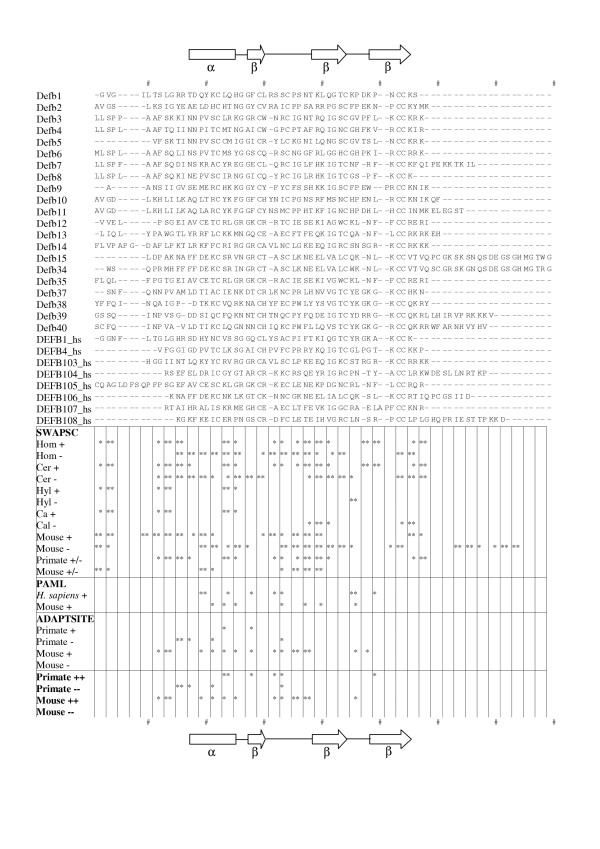
Alignment of human and mouse β-defensin peptides showing sites of selection. Sites of significant positive and negative selection (according to SWAPSC, PAML and ADAPTSITE) in primate and mouse lineages are indicated by asterisks. Hashes indicate every tenth position in the alignment. Hominidae, Cercopithecidae, Hylobatidae and Callitrichidae are abbreviated to Hom, Cer, Hyl and Cal respectively. The positions of the beta strands and alpha helix in DEFB1 are indicated, the residues within the prepropeptide region are those before the alpha helix. The horizontal lines under the alignment denote the results of different analyses: SWAPSC results for primate and mouse lineages individually, SWAPSC sites under positive and negative selection in different branches within primates (Primate +/-) and mouse (Mouse +/-), PAML results for sites under positive selection, ADAPTSITE results for sites under positive an negative selection, sites implicated as under positive selection by two or more different programs for primate (Primate ++ and Primate --) and mouse (Mouse ++ and Mouse--) lineages.